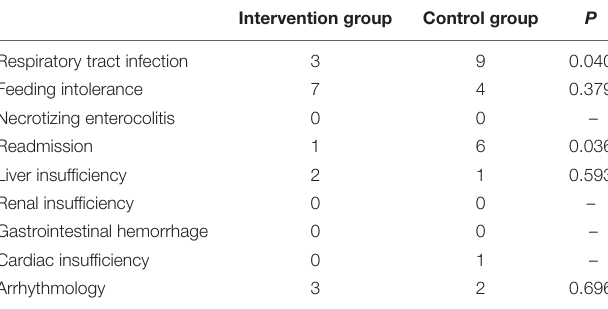
TABLE 3 | Comparison of complications between the two groups during 3 months follow-up